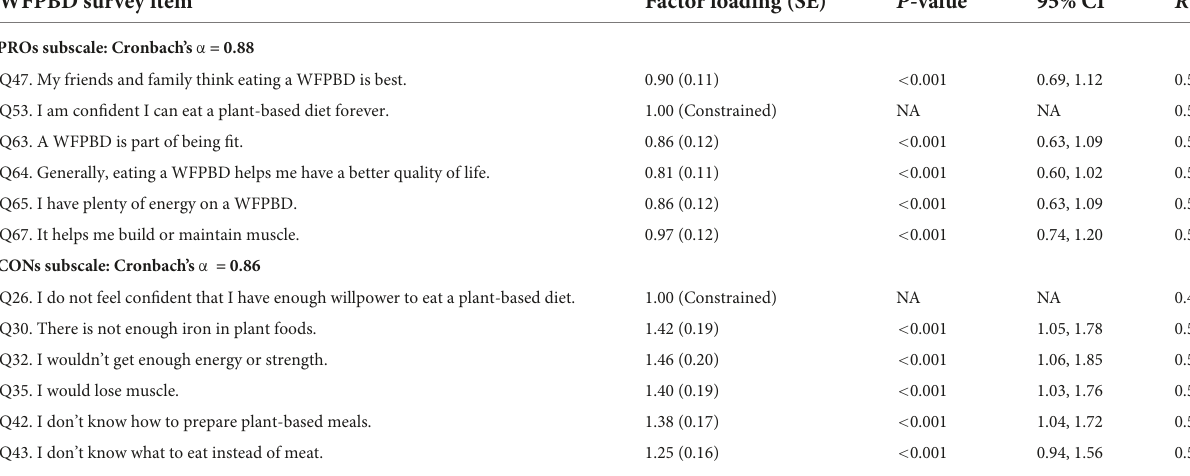
TABLE 2 Factor loadings (SE), p -values, 95% CI’s, and R-squared statistics for the final WFPBD following confirmatory factor